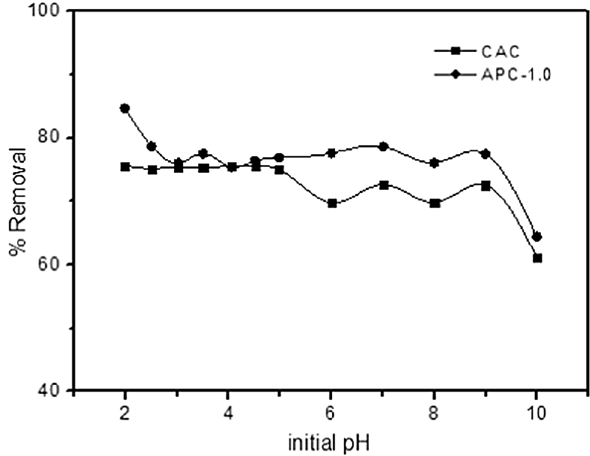
Fig. 3 Dependence of pH on the adsorption capacity of PR-5B dye on CAC and APC-1.0. Conditions: temperature, 298 K; adsorbent mass, 50.0 mg; time, 8 h; pH, 2–10; dye concentration, 500 mg L